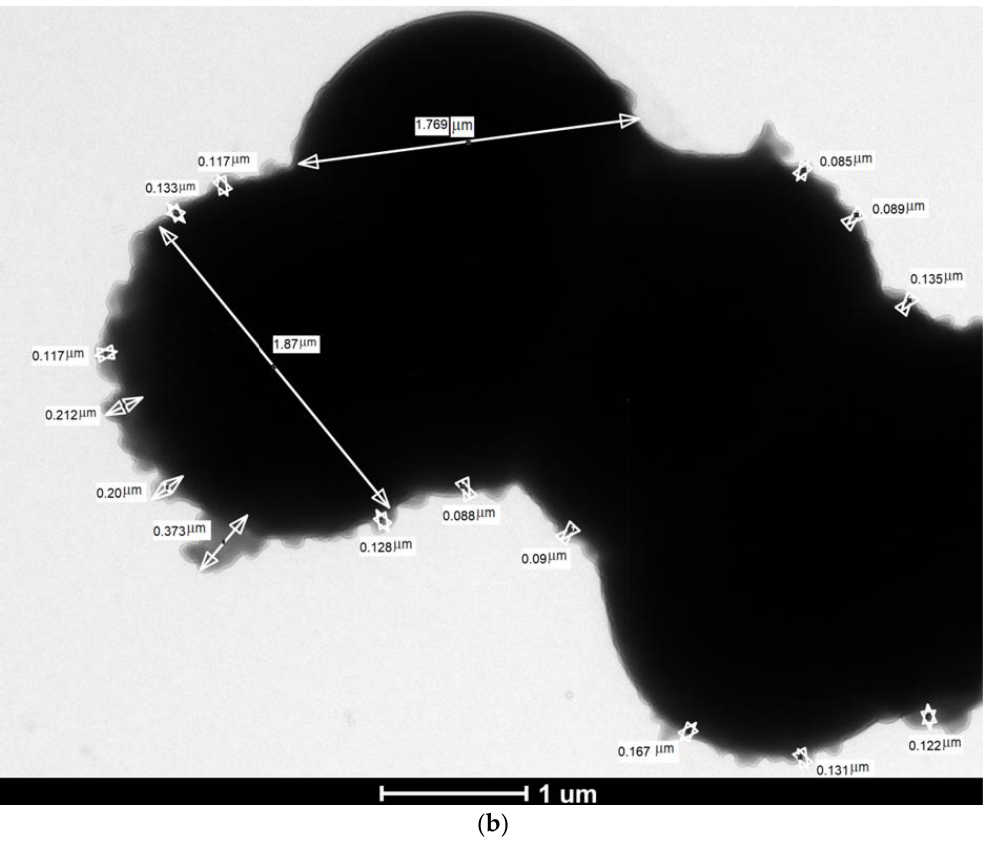
Figure 7. Trial-2 microcapsule TEM images at scales of ( a ) 500 nm and ( b ) 1µm.